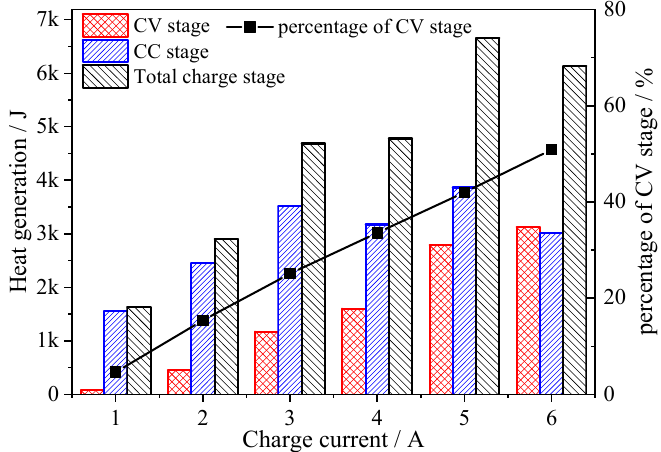
Figure 3. Effect of operating current on heat generation during the charge stage.